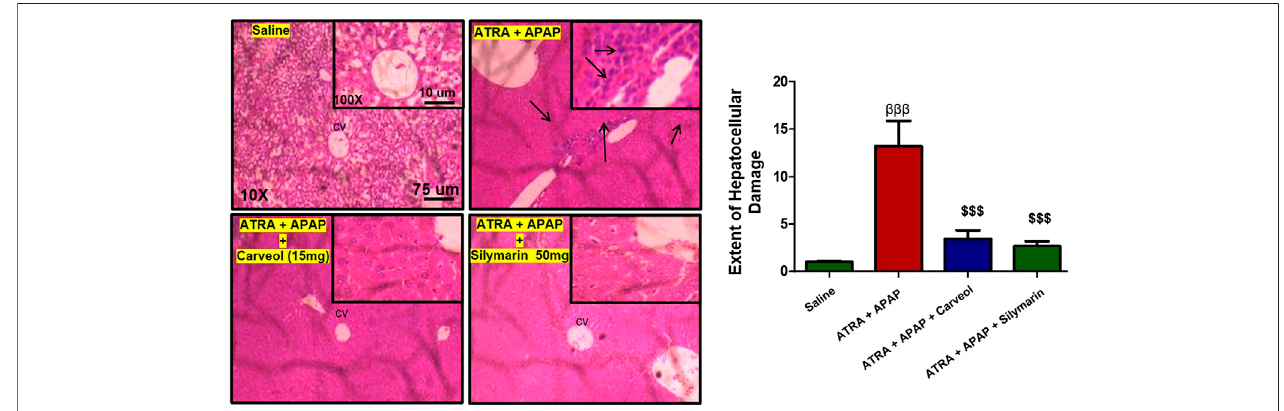
Figure 8 | Histological examination and morphological changes in liver tissues. Liver tissues stained with H and E (magni fi cation × 10 and 40 × ) ( n (cid:1) 5/group). The necrotic cells are marked and shown by an arrow; abundant in fl ammatory cell in fi ltration can be seen in the APAP + ATRA group. The data are presented as means ± SEM and were analyzed using one-way ANOVA followed by Tukey ’ s multiple comparison test. The symbols βββ and $$$ represent signi fi cant difference values of p < 0.001,thesymbol β showsasigni fi cantdifferencerelativetothesaline,andthesymbol$showsasigni fi cantdifferencerelativetotheAPAP+ATRAgroup.The slides were processed from cohort 2.